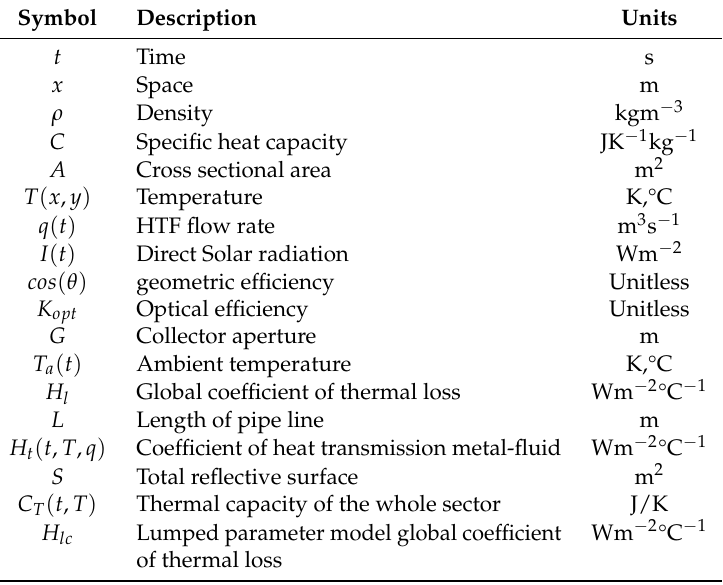
Table 1. Parameters